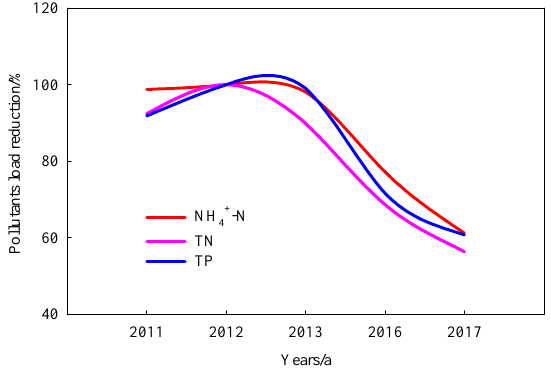
Figure 8. Pollutant load reduction with monitoring time. Note: Combined with runoff reduction, the annual average load reduction rate of NH 4+ –N, TN and TP in rain garden No. 1A from 2011 to 2017.